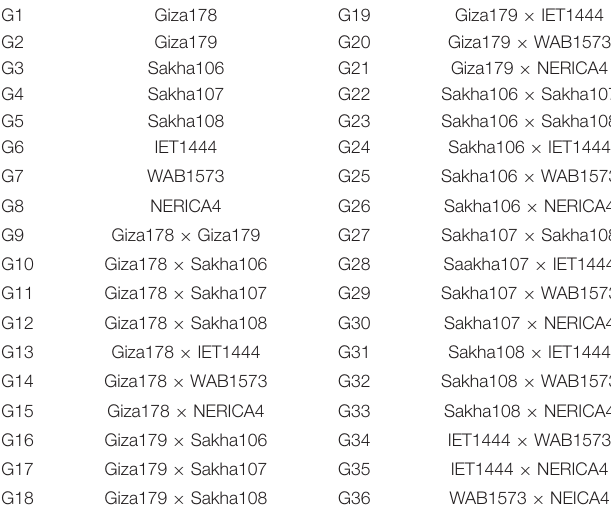
TABLE 6 | Abbreviations of genotypes.